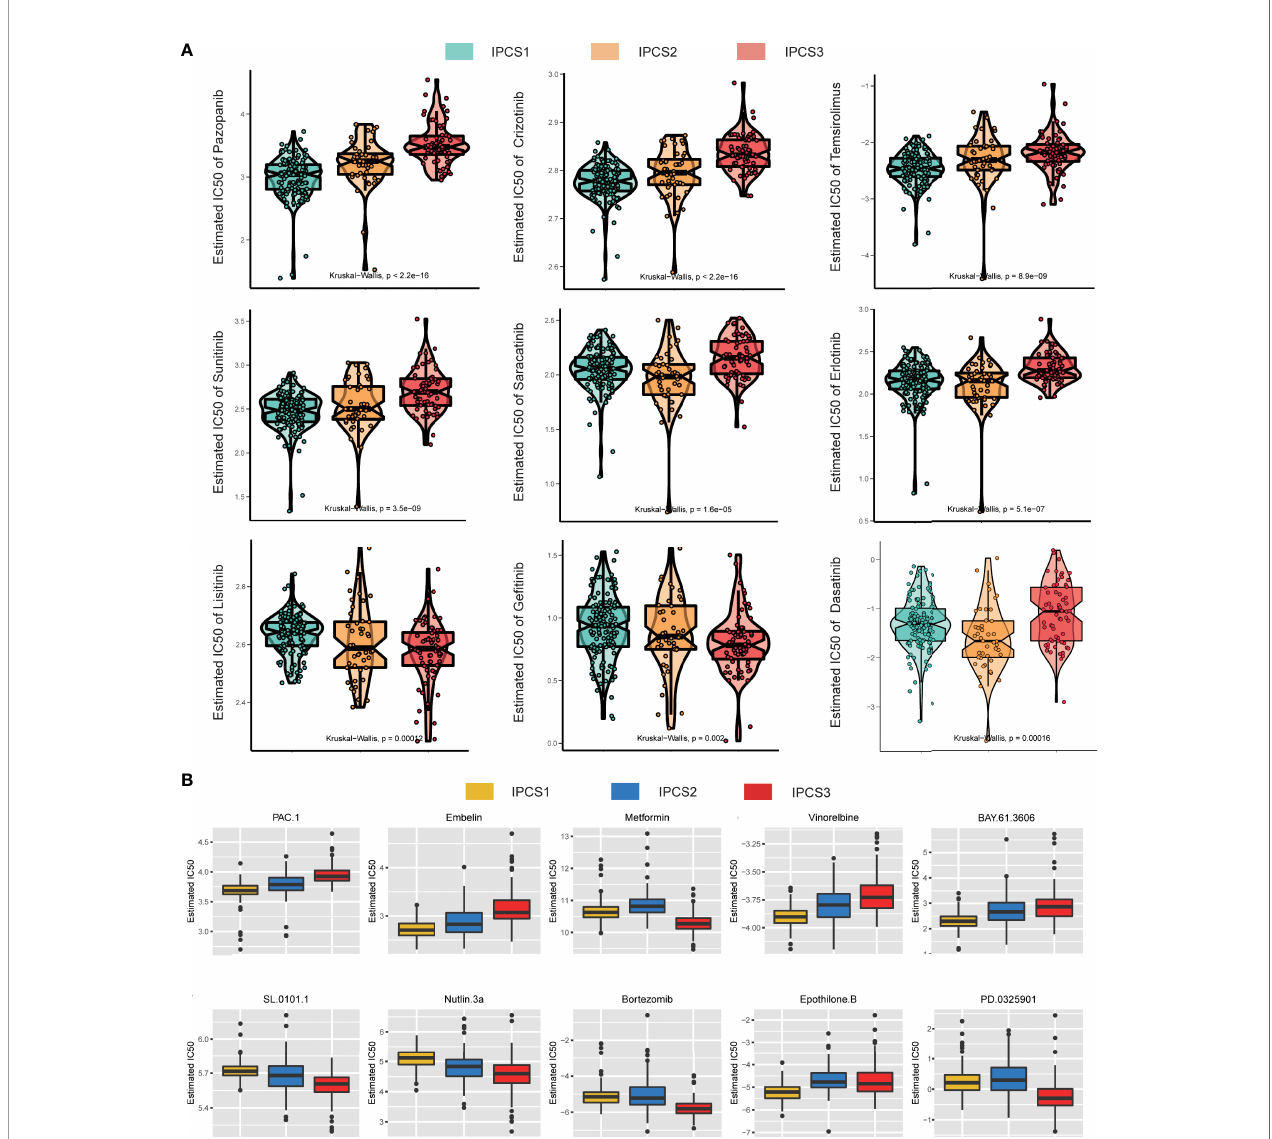
FIGURE 8 | Drug sensitivity analysis of three subtypes. (A) Estimated IC 50 of the indicated molecular-targeted drugs among the three subtypes. (B) Estimated IC 50 of the potential molecular inhibitors in IPCS1, IPCS2, and